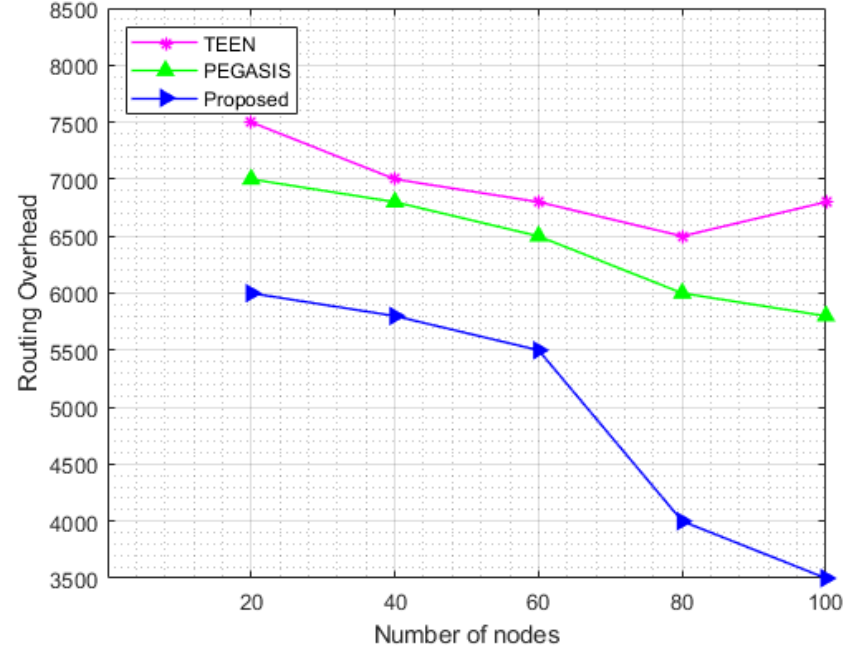
Figure 10. Number of nodes vs. Routing Overhead (100 nodes).